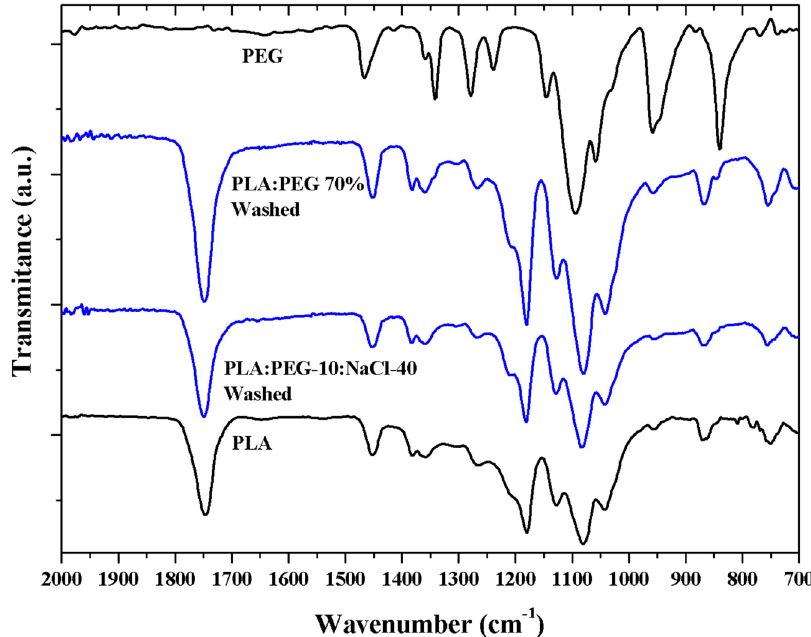
Figure 10. FTIR spectra of PLA:PEG 70% and PLA:PEG-10:NaCl-40 specimens after immersion in a water medium. For comparison purposes spectra of PLA and PEG micromolded specimens are also given.